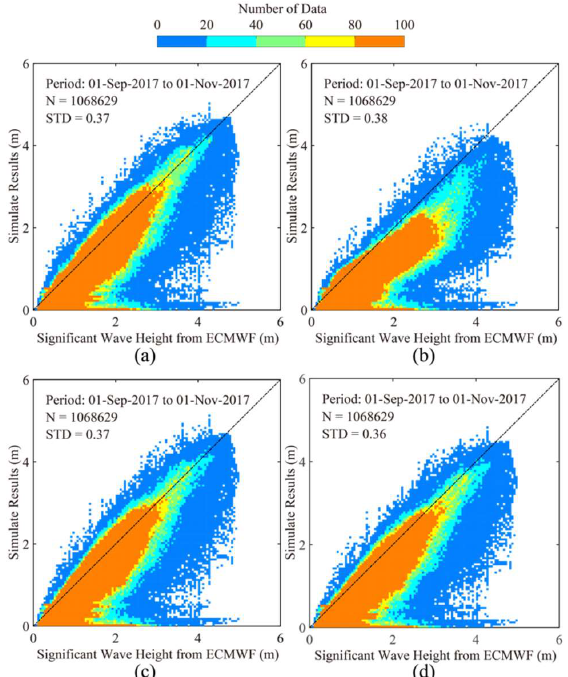
Figure 6. The comparisons between simulated results and SWH from ECMWF, in which the color represents the amount of data. ( a ) simulated results using the DIA package; ( b ) simulated results using the WRT package; ( c ) simulated results using the GMD1 package; ( d ) simulated results using the GMD2 package.